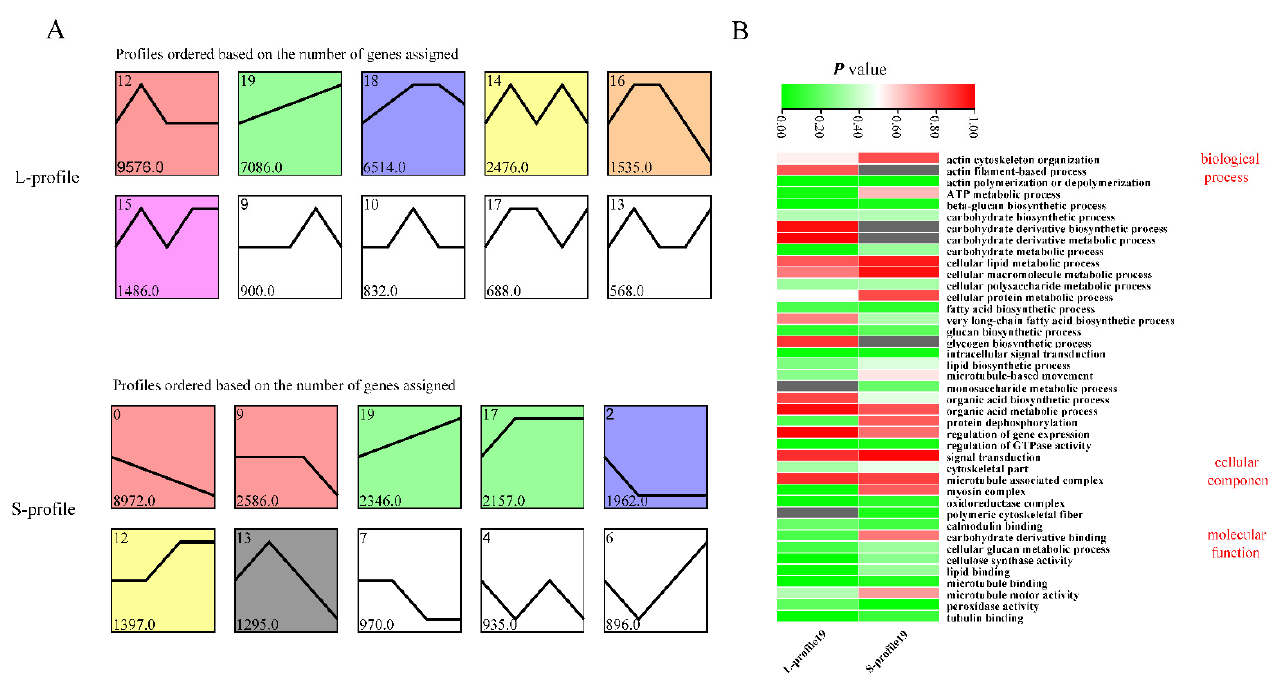
Figure 4. Gene expression patterns of L and S and GO enrichment of profile 19. ( A ) Gene expression patterns for the four developmental stages of L and S as inferred from STEM analysis. Each square represents the expression trend, and the text indicates the number of genes and IDs contained in the profile. ( B ) GO enrichment of L and S in Profile 19. The p value indicates the significance of GO terms. Gray represents no enrichment.